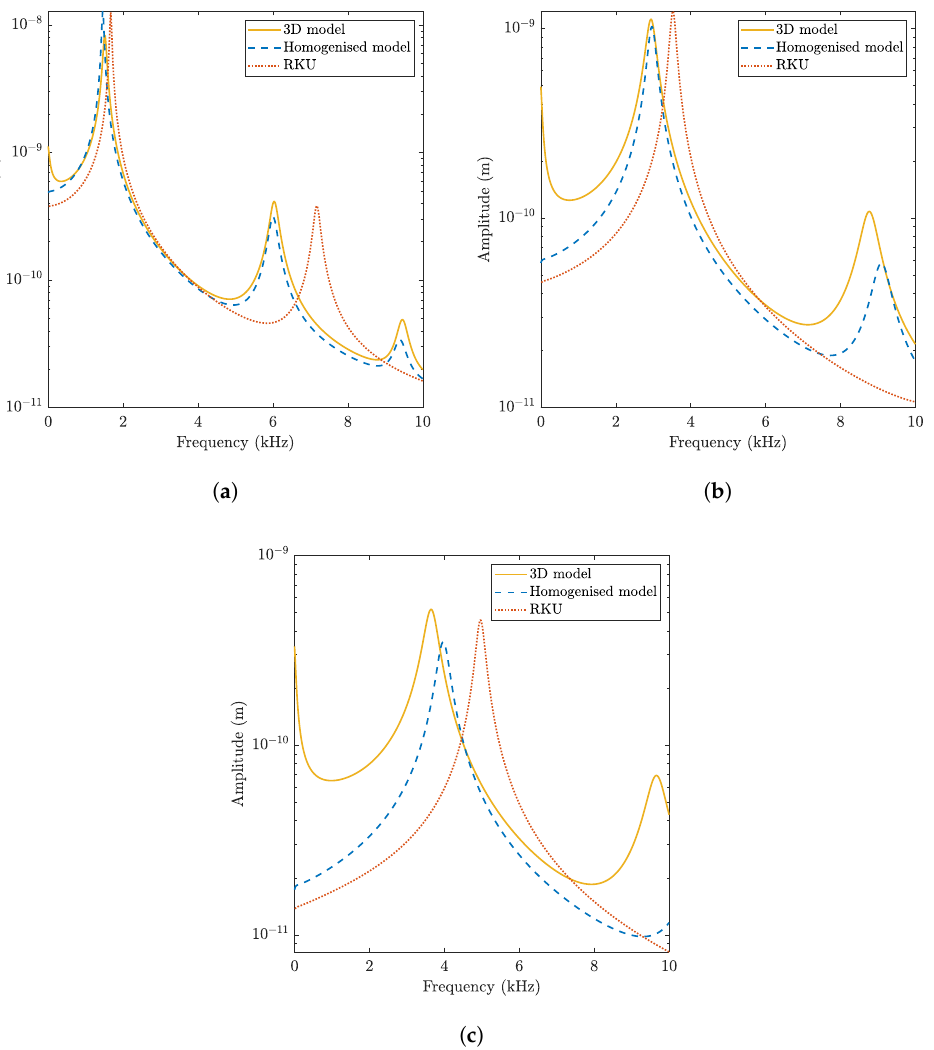
Figure 7. Amplitude of the transverse displacement of the simply supported CLD plate when subjected to a unit pressure: ( a ) H 2 = 1 mm; ( b ) H 2 = 5 mm; ( c ) H 2 = 10